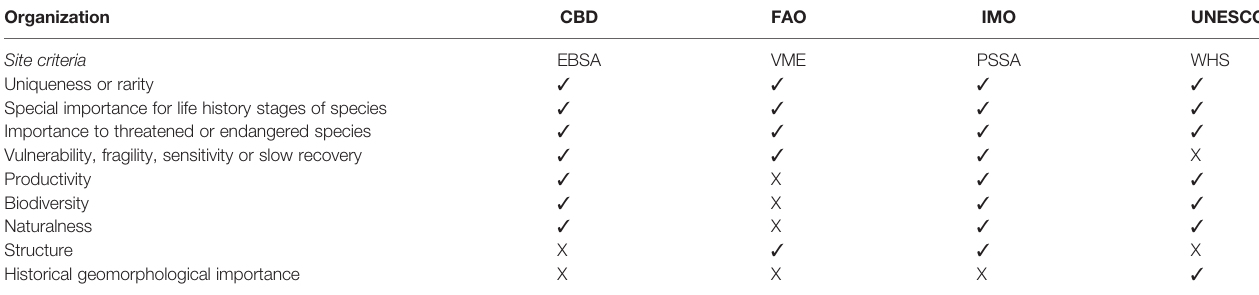
TABLE 1 | 1 Correspondence between the CBD EBSA criteria and other international criteria used by